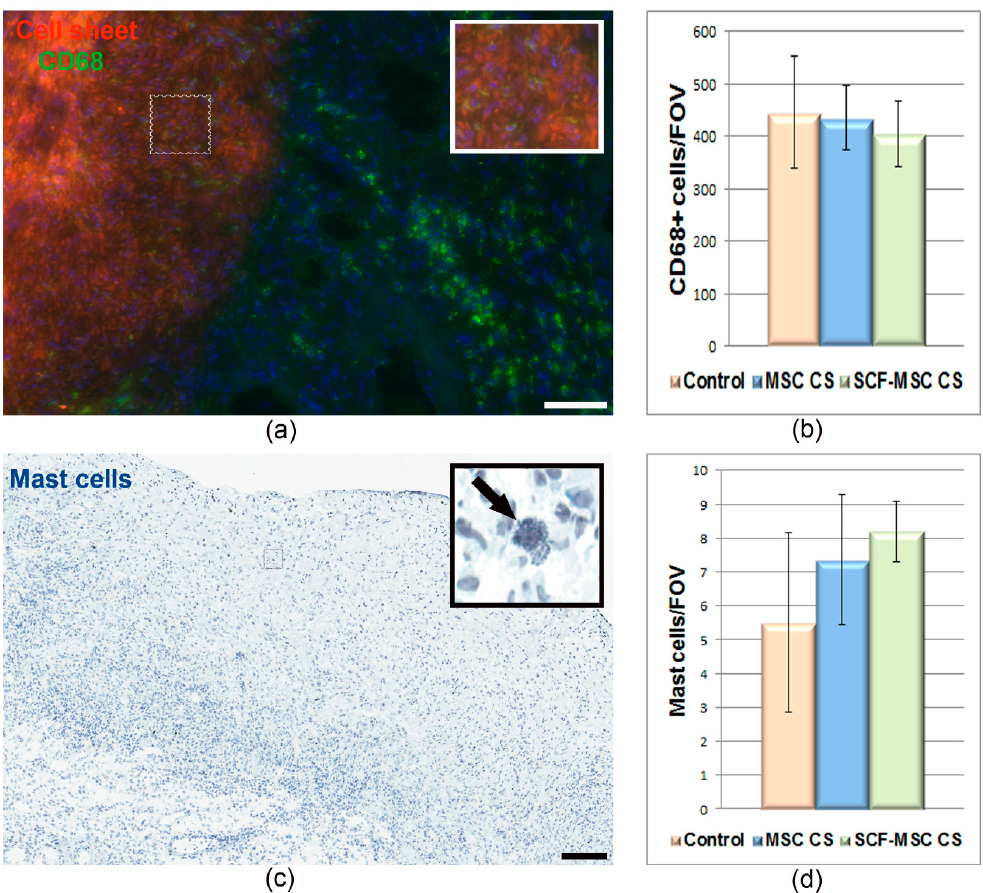
Figure 4. Macrophages and mast cells count at day 5 following MI induction and CS transplantation. ( a ) A representative image of myocardium section stained against CD68 (green), a marker of macrophages/monocytes. Nuclei are stained with DAPI. Scale bar-100 µm. The small square bar indicate the area of the section where the magnified view (large square bar) was taken from; ( b ) CD68+ cell count in the sham-operated, MSC CS and SCF-MSC CS groups. Data are presented as mean ± SD (Mann–Whitney U-test); ( c ) A representative image of myocardium section stained with toluidine blue to identify the mast cells. Scale bar-100 µm. The small square bars indicate the area of the section where the magnified view (large square bars) was taken from; ( d ) Mast cells count in the sham-operated, MSC CS and SCF-MSC CS groups. Data are presented as mean ± SD (Mann–Whitney U-test).